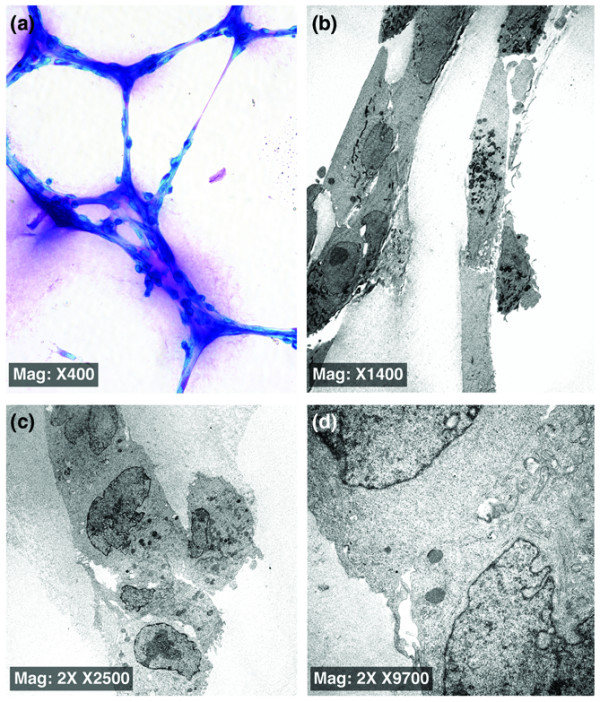
PAS staining and electron microscopic analysis of vascular channels formed by MDA-MB-231 cells. (a) PAS staining was performed on MDA-MB-231 cells plated on matrigel for 24 hours to identify the extracellular matrix secreted by cells. Pink staining refers to the glycogen and related mucopolysaccharides secreted by the cells to form the extracellular matrix-rich vascular channels. (b) Transmission electron microscopic analysis was performed on MDA-MB-231 cells plated on matrigel for 24 hours. A cluster of cells came into contact with each other to form vascular channels. There was cytoplasmic ruffling and protrusion at cell contact position. (c) There was evidence of stretching of cellular contents to form the tubular channel-like structure. (d) Absence of tight junctions between adjacent cells involved in vascular channel formation was observed. PAS, periodic acid-Schiff.